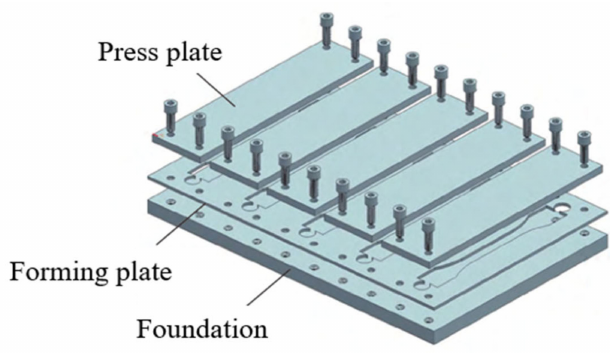
Figure 3. Standard model for dumbbell-shaped specimen.